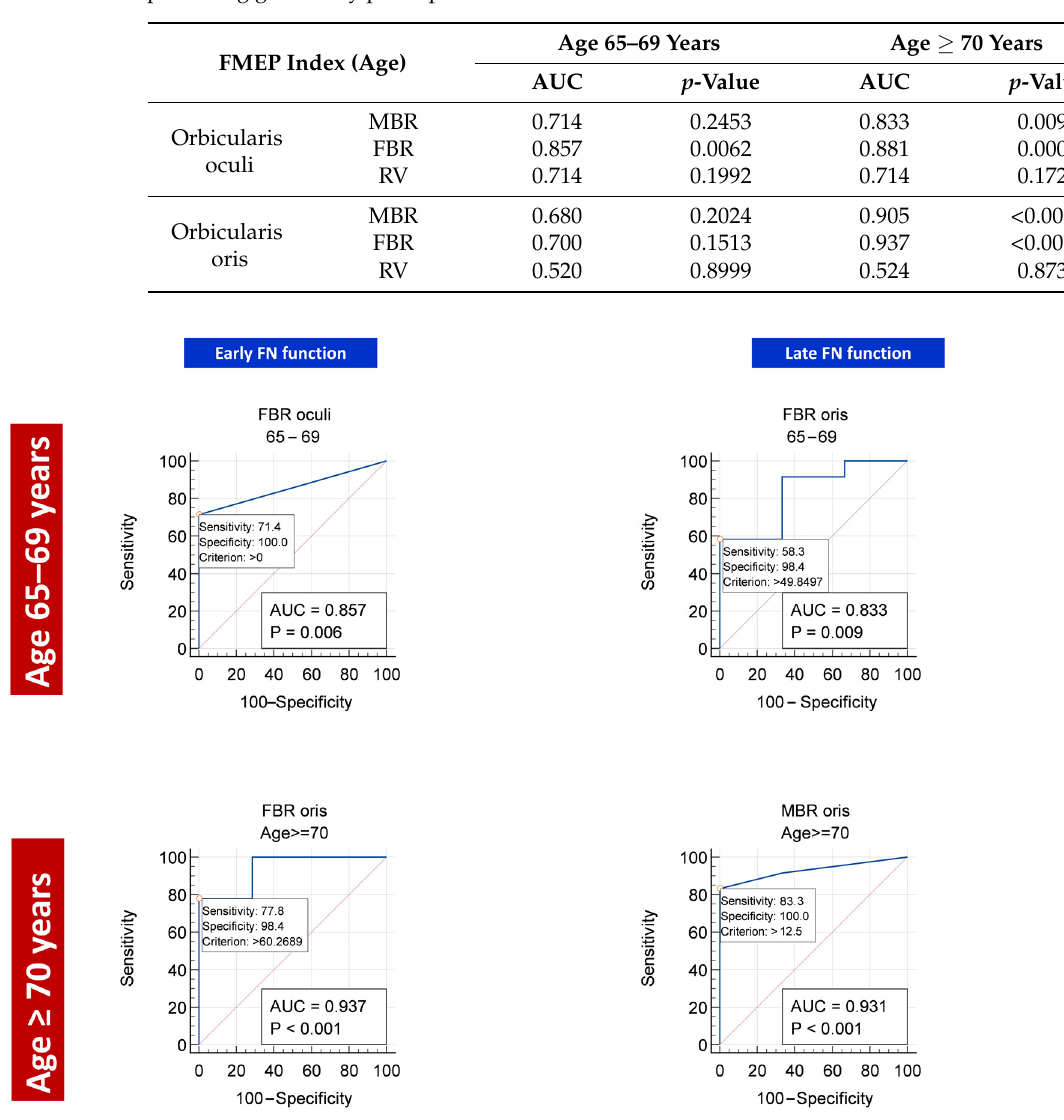
Table 3. Area under the curve (AUC) of ROC curves analyzing the accuracy of FMEP indices in predicting good early post-operative FN function.